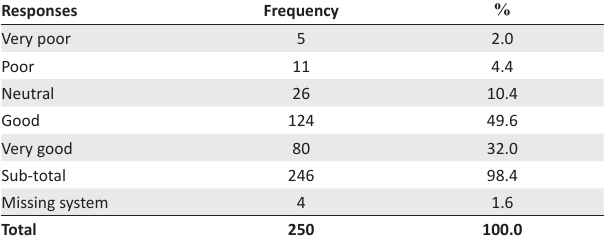
TABLE 2: Priority for satisfying students with added products and services. Responses